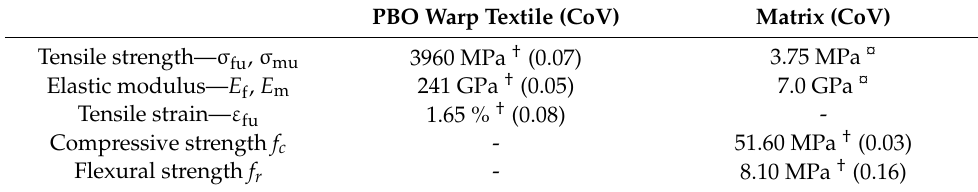
Table 1. Mechanical properties of fiber textile and